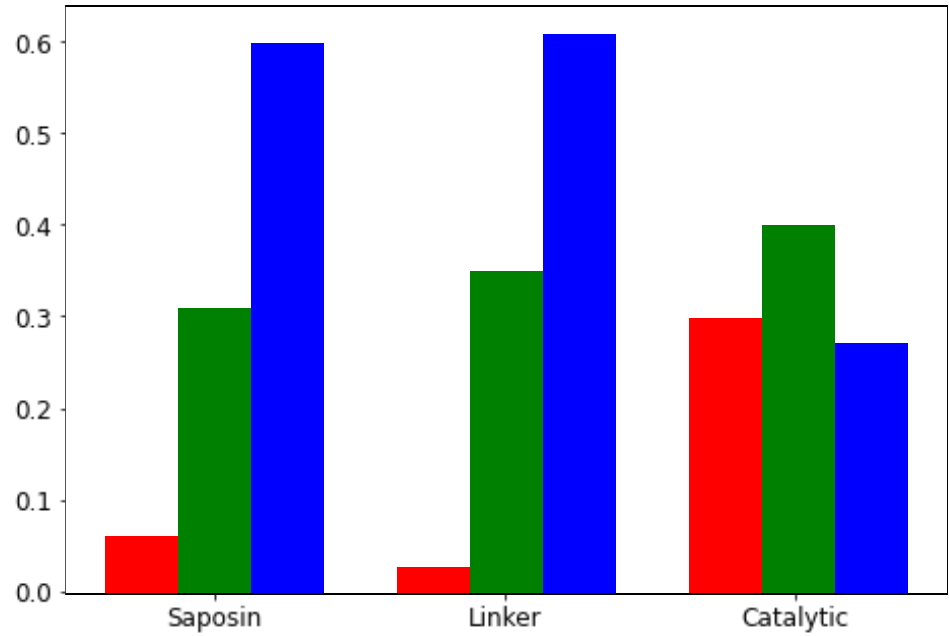
Figure 4. Fraction of variants predicted as neutral (blue), NPDB-associated (green) or NPDA- associated (red) using SMPD1-ZooM, at all sequence positions in the different SMPD1 domains (saposin, proline-rich linker and catalytic domains). The differences between the fractions are all statistically significant according to a proportion Z-test, except the difference between the fractions of neutral variants in the saposin and linker regions, and similarly for the NPDB-associated